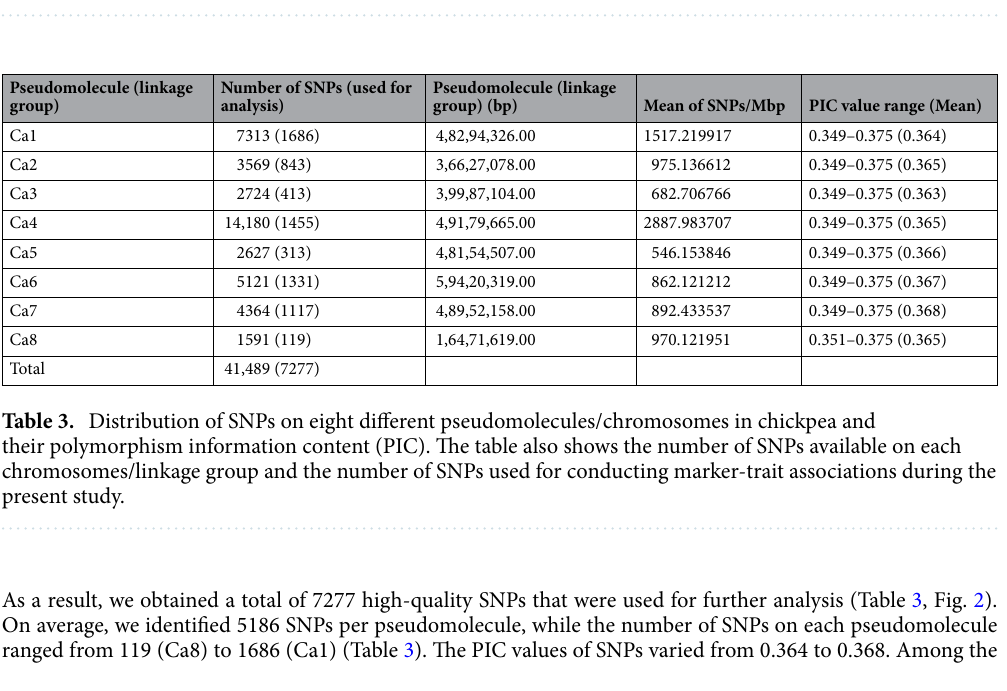
Number of SNPs (used for